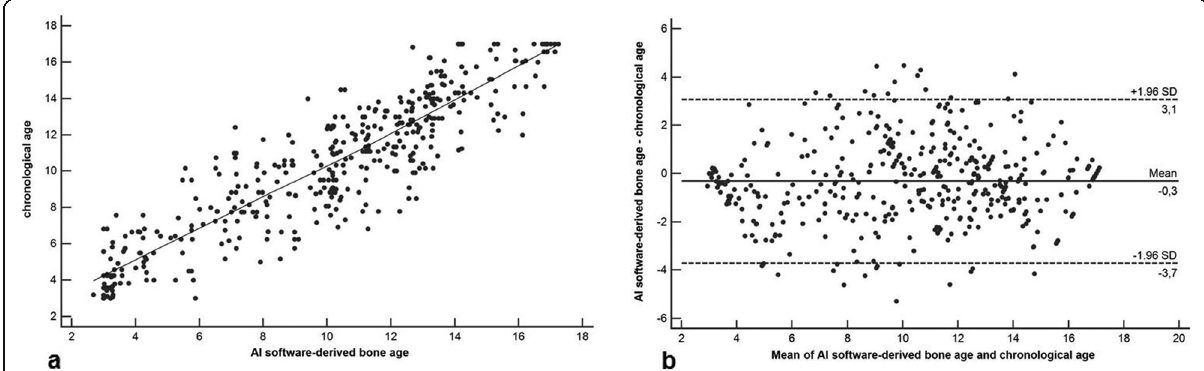
Fig. 5 Correlation and agreement analysis of BoneXpert version 2.1-derived BA values and chronological age values. a Pearson product-moment correlation demonstrates excellent correlation with r = 0.912, 95% confidence interval (CI) 0.856 – 0.965, and r 2 = 0.832, 95% CI 0.801 – 0.862. b Bland- Altman plot shows excellent agreement between software-derived BA values and chronological age values. Values are given in years. AI Artificial intelligence, BA Bone